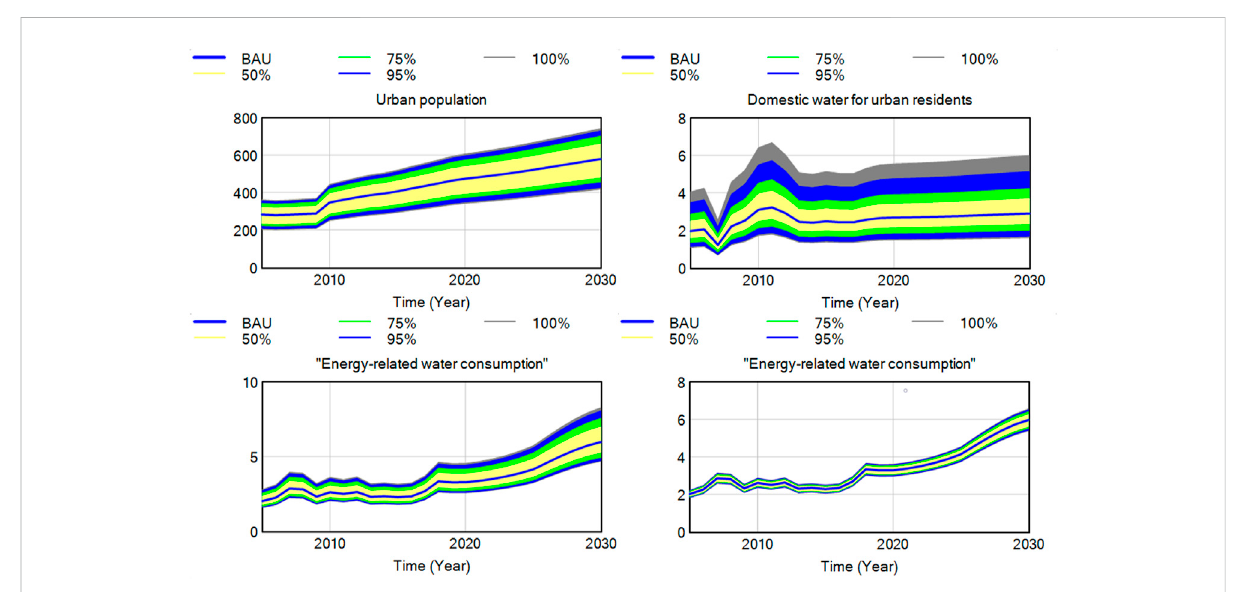
FIGURE 4 Sensitivity Response of urban population, domestic water for urban residents and energy-related water